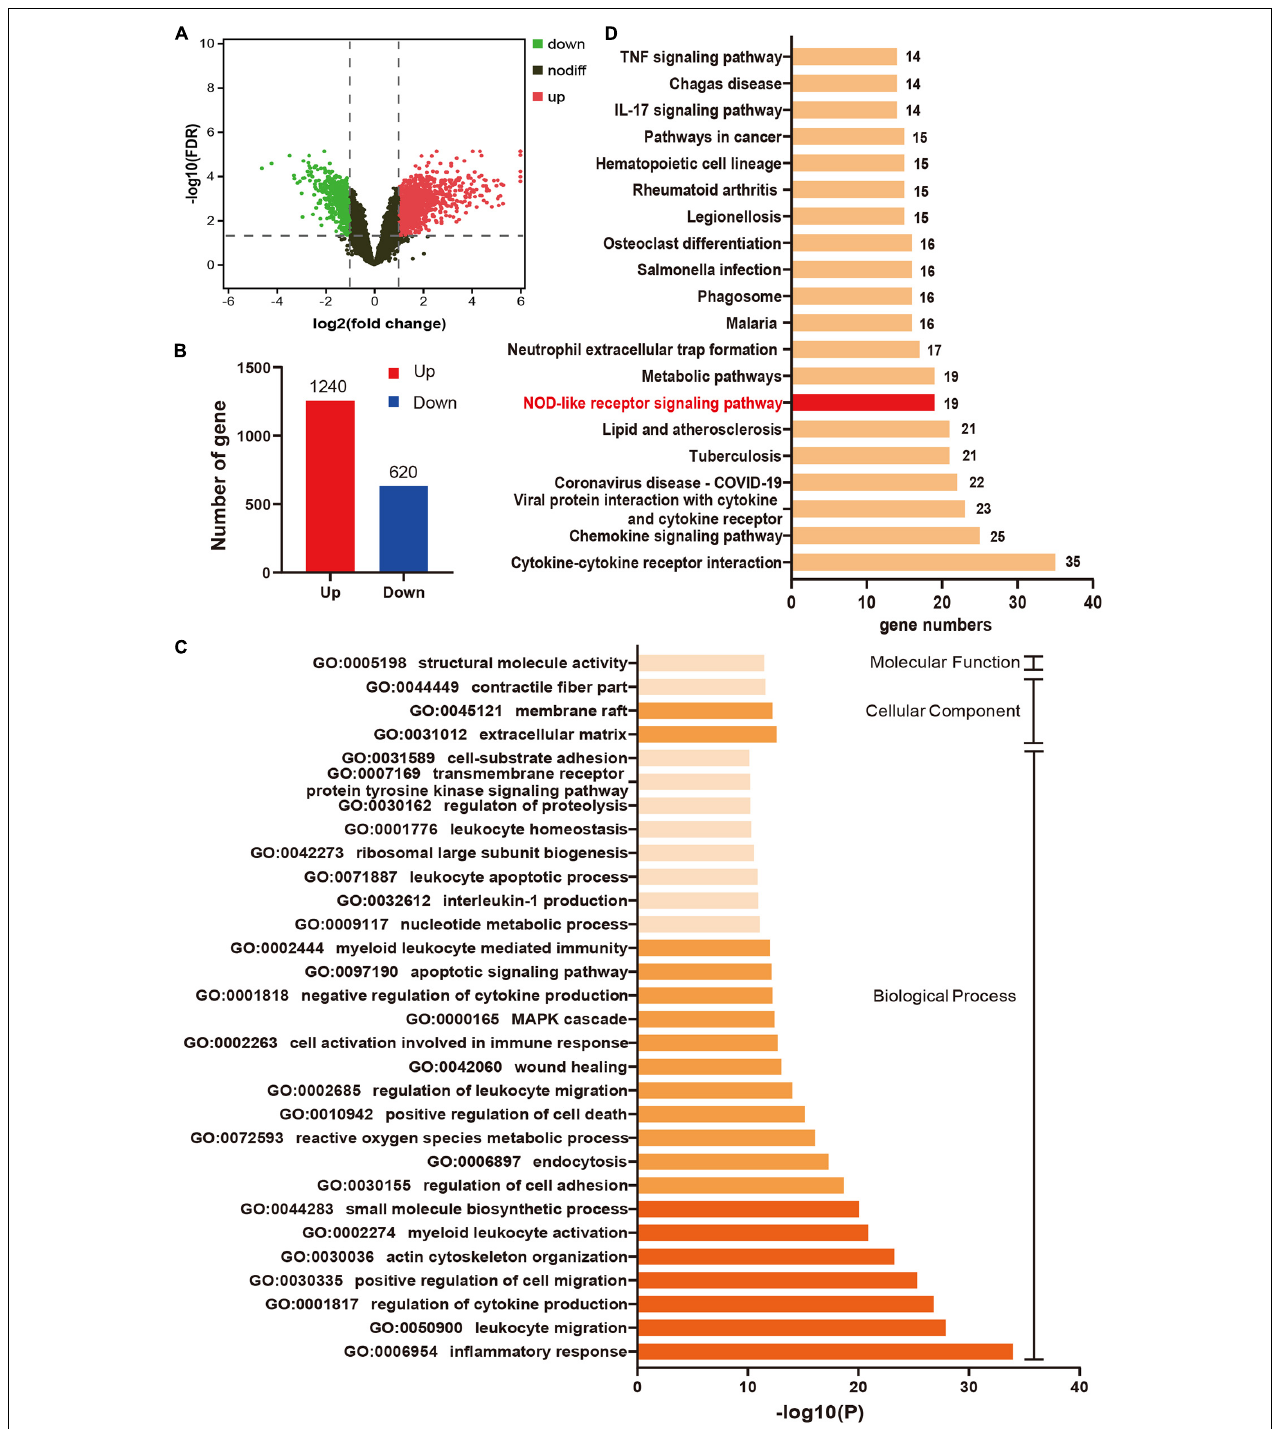
FIGURE 2 | Inflammatory response mediated by NOD-like receptor signaling pathway plays an important role in myocardial I/R injury. (A) Volcano plot for DEGs between IR24h samples and sham samples. Red dots and green dots respectively represent up-regulated and down-regulated genes in IR24h samples compared to sham samples (adjusted p -value < 0.05 and | log 2 FC| ≥ 1). Black dots indicate the genes without significant expression difference between the two groups (adjusted p -value ≥ 0.05 or | log 2 FC| < 1). (B) The number of up-regulated and down-regulated genes in IR24h samples compared to sham samples. (C) Heatmap of GO analysis enriched terms colored by p -value. GO functional enrichment analysis classified the DEGs into three functional groups: molecular function group, biological process group, and cellular component group. (D) KEGG pathway analysis for the DEGs enriched in GO:0006954. NOD-like receptor signaling pathway is marked with red color. DEGs, differentially expressed genes; log 2 FC, log 2 (fold change); GO, Gene ontology; KEGG, Kyoto Encyclopedia of Genes and Genomes.